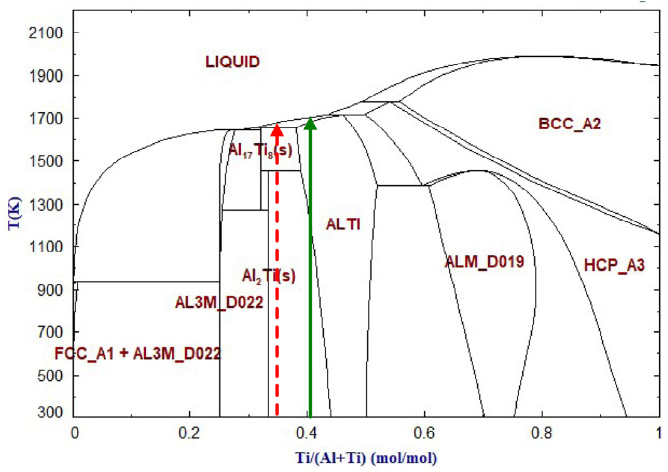
Figure 5. Binary phase diagram of Ti and Al from FactSage 7.3 databases [33].